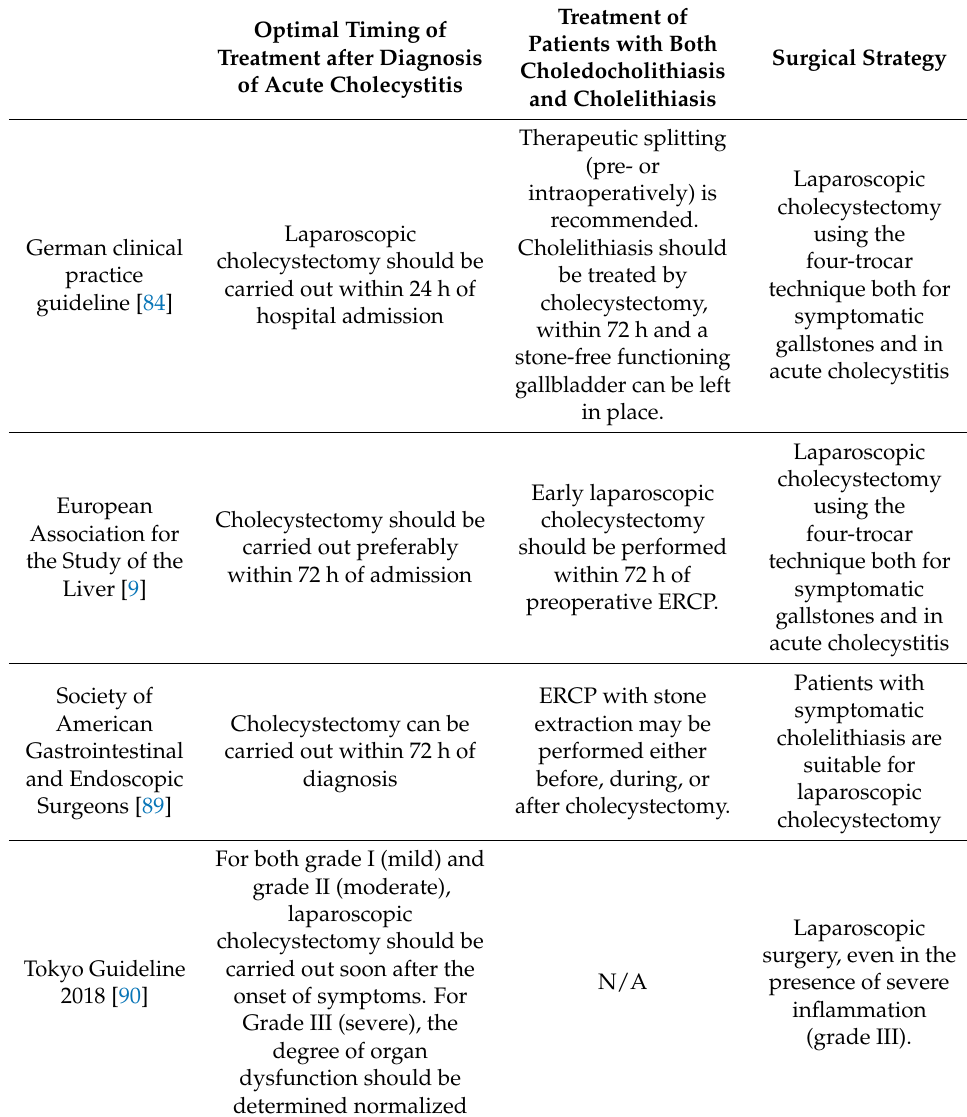
Table 5. Differences in recommended treatment